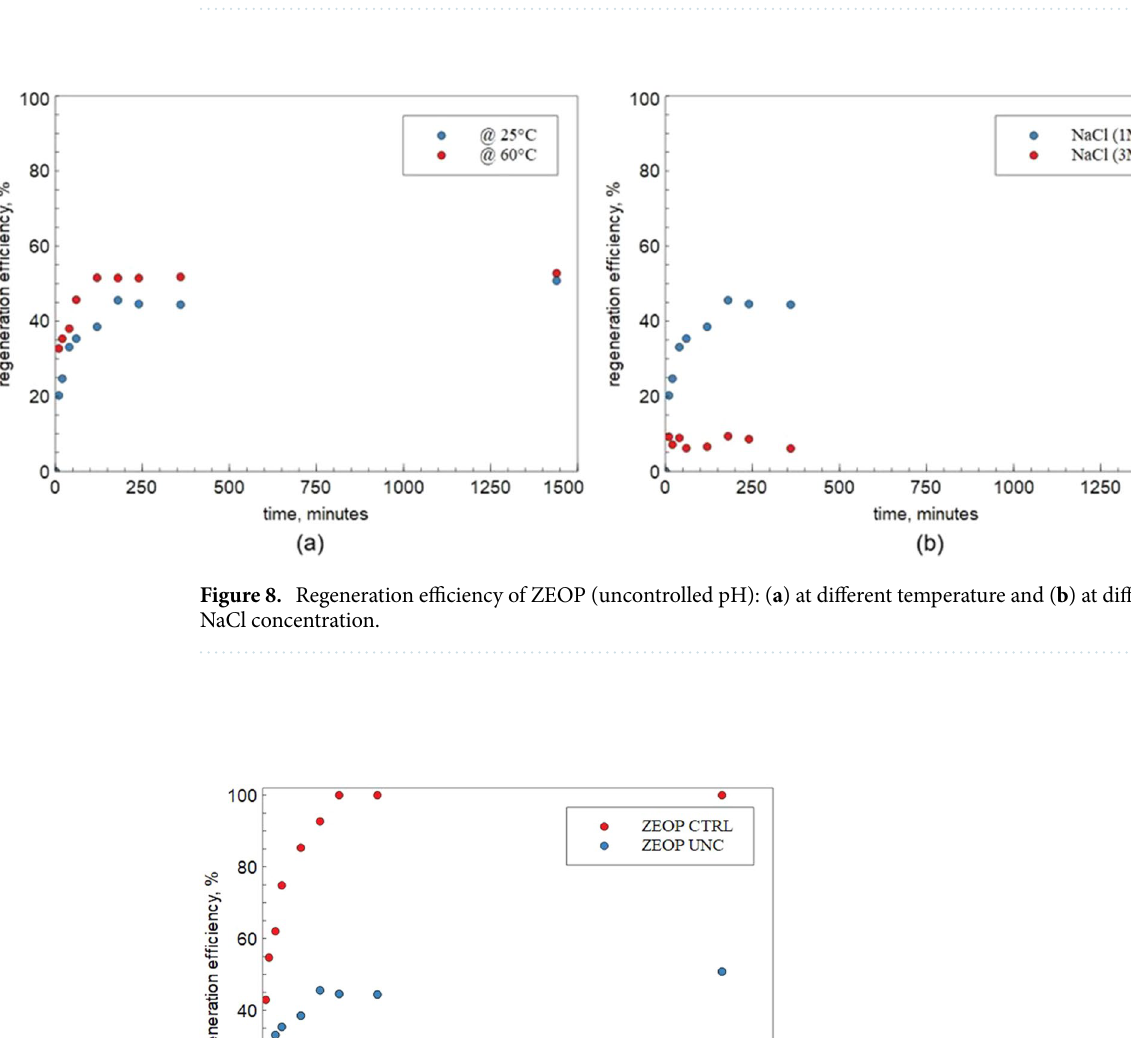
Table 3. Removal efficiency of calcium and magnesium compared to the literature. * At pH = 5 the softening is merely based on cation exchange.